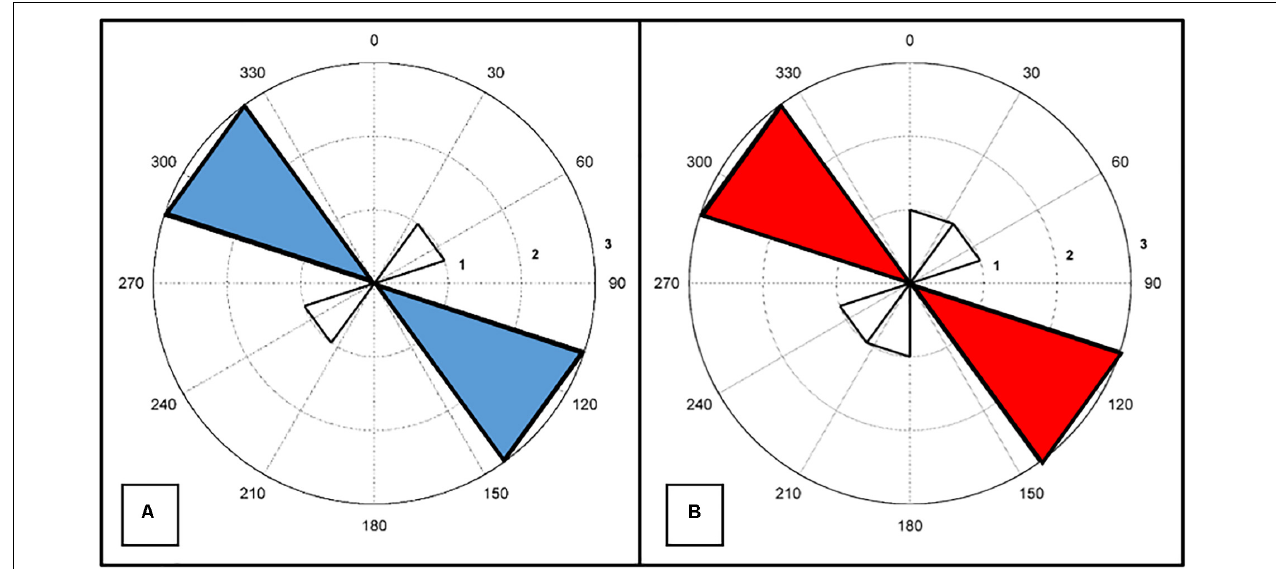
FIGURE 9 | Rose diagrams related to the trend of maximum elongation axis of the clusters of cones (A) and cone bases (B) .